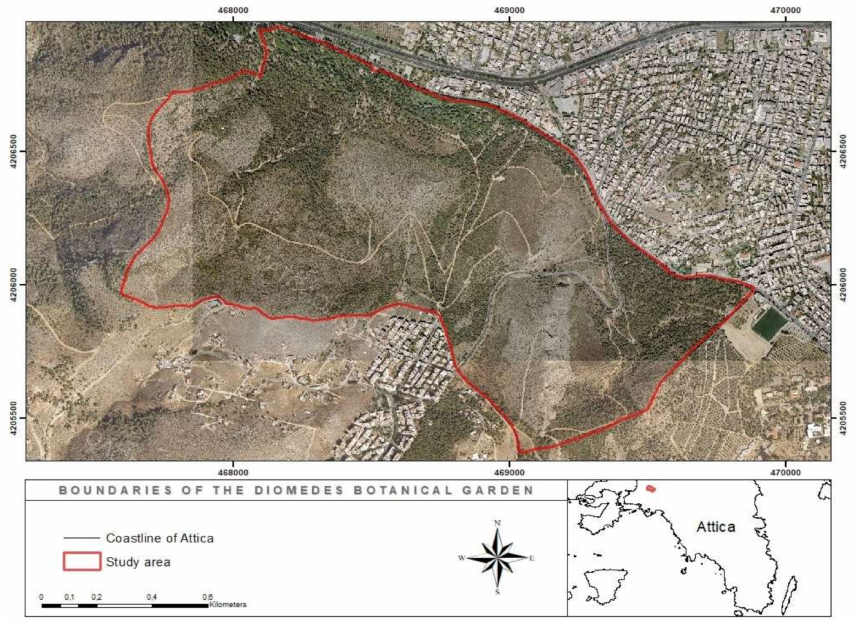
Figure 1. The boundaries of the study area located west of